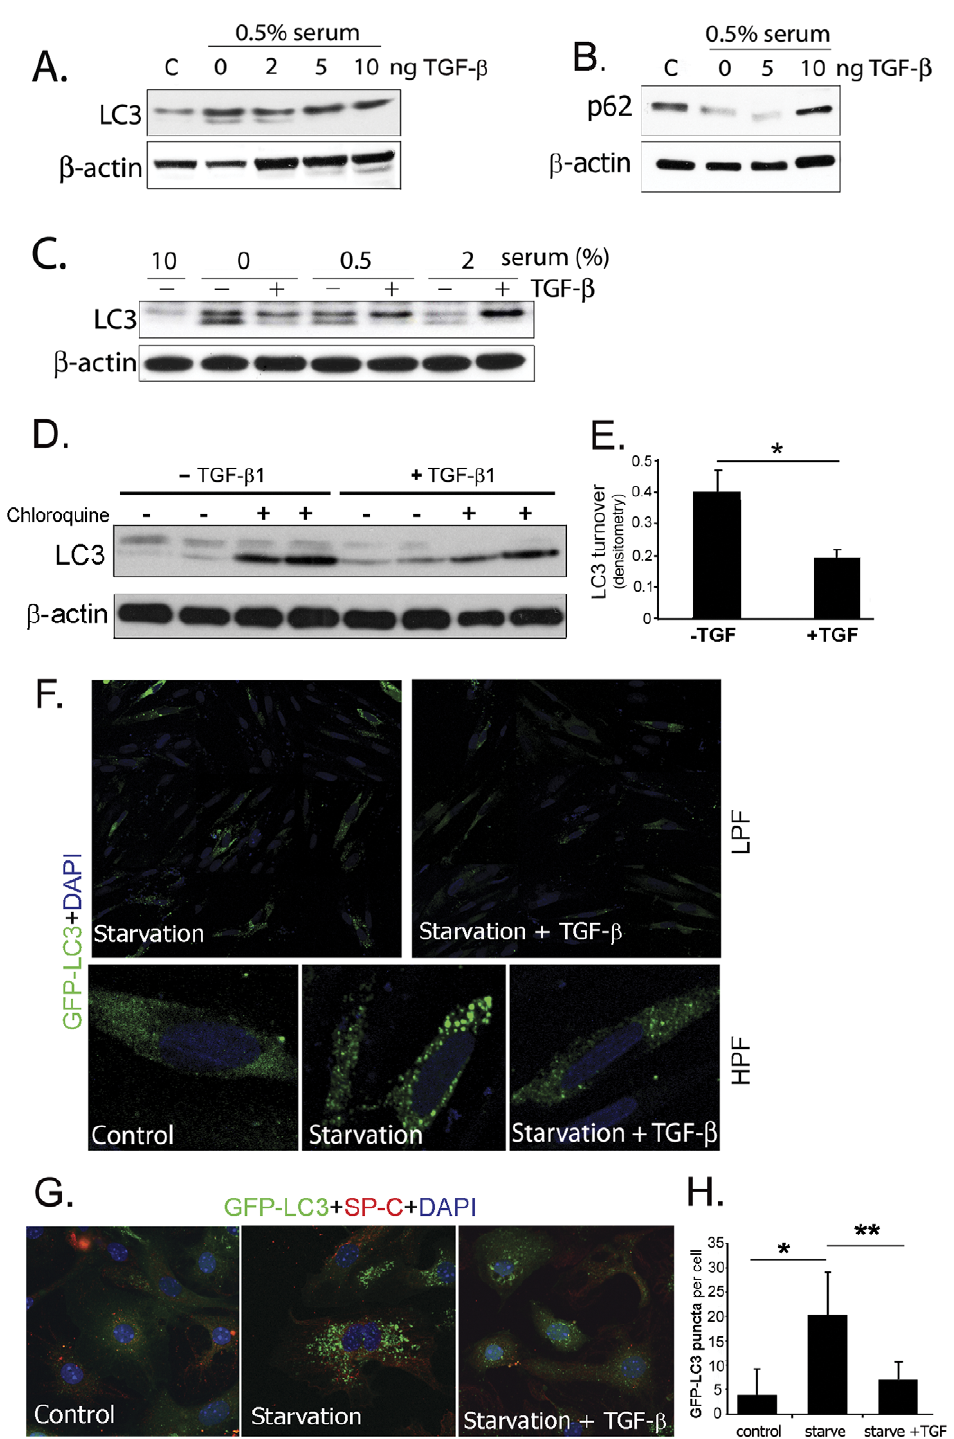
Figure 2. TGF- b 1 inhibits autophagy invitro . A) Human lung fibroblasts were cultured and treated with varying concentrations of TGF- b 1 . TGF- b 1 inhibited activation of LC3, decreasing the intensity of the lower band on the western blot, and B) increased p62. C) Inhibition of LC3 activation by TGF- b 1 with varying serum conditions. D) Fibroblasts treated with TGF- b 1 for 24 hours and measurement of autophagic flux by LC3 western blotting (using lysosomal acidification inhibitor chloroquine). E) Densitometry of western blot shown in D (p=0.045). F) Fluorescence microscopy of fibroblasts transfected with GFP-LC3 construct and stimulated with TGF- b 1 showing that TGF- b 1 inhibits formation of LC3 puncta. G) Confocal microscopy of type II alveolar epithelial cells isolated from GFP-LC3 transgenic mice and stimulated with TGF- b 1 showing that TGF- b 1 inhibits formation of LC3 puncta (green=GFP-LC3, red=SP-C, blue=DAPI). H) Quantification of GFP puncta per cell from figure 2G.